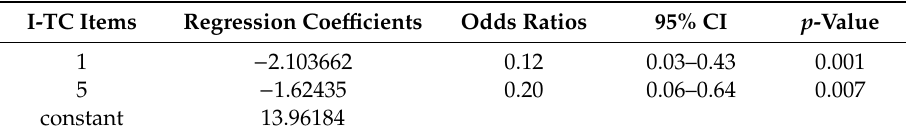
Table 5. Results of the multivariate logistic regression analysis stepdown procedure on the association between diagnosis of ASD or BAP at 36 months and I-TC items significantly associated at the bivariate logistic regression at 18 months of age (Items 1 to 7).